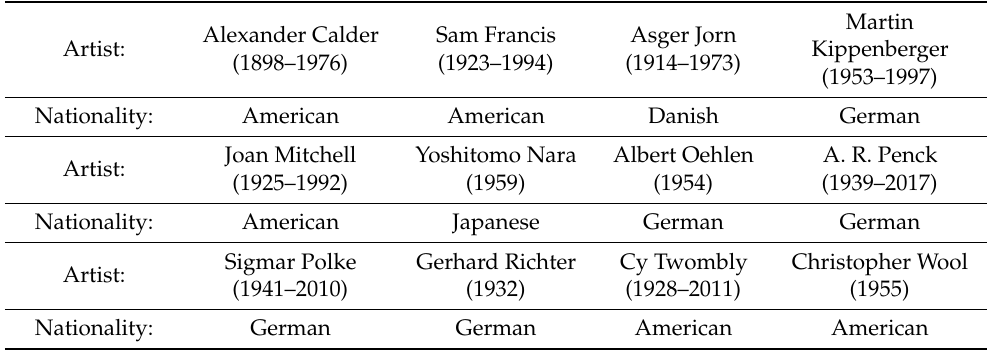
Table 1. List of